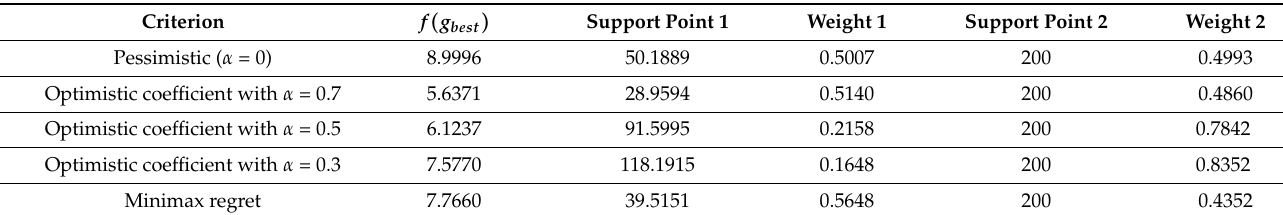
Table 5. Different criterion with Michaelis–Menten model.